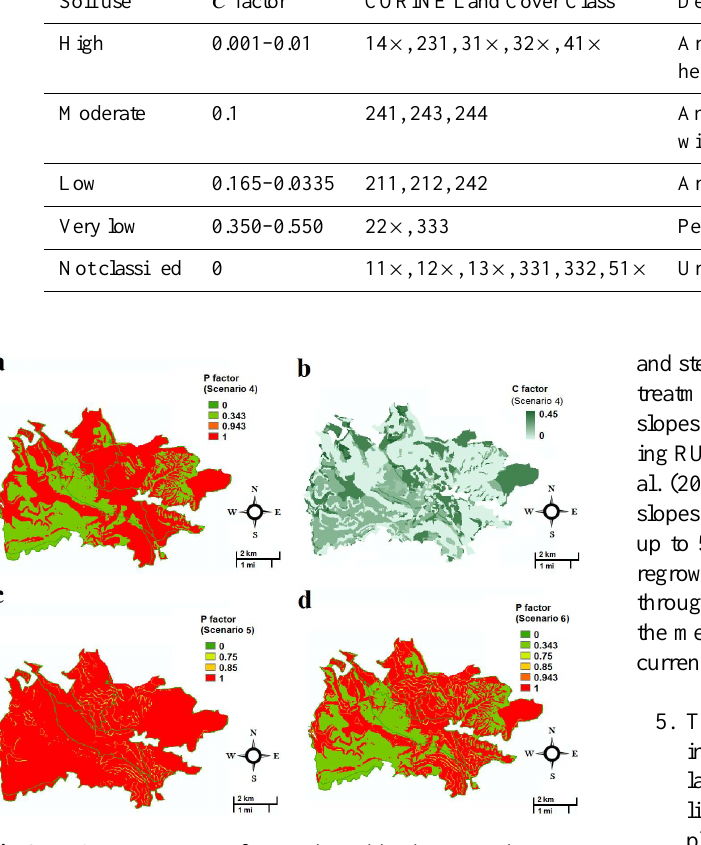
Fig. 3. RUSLE parameters after erosion mitigation